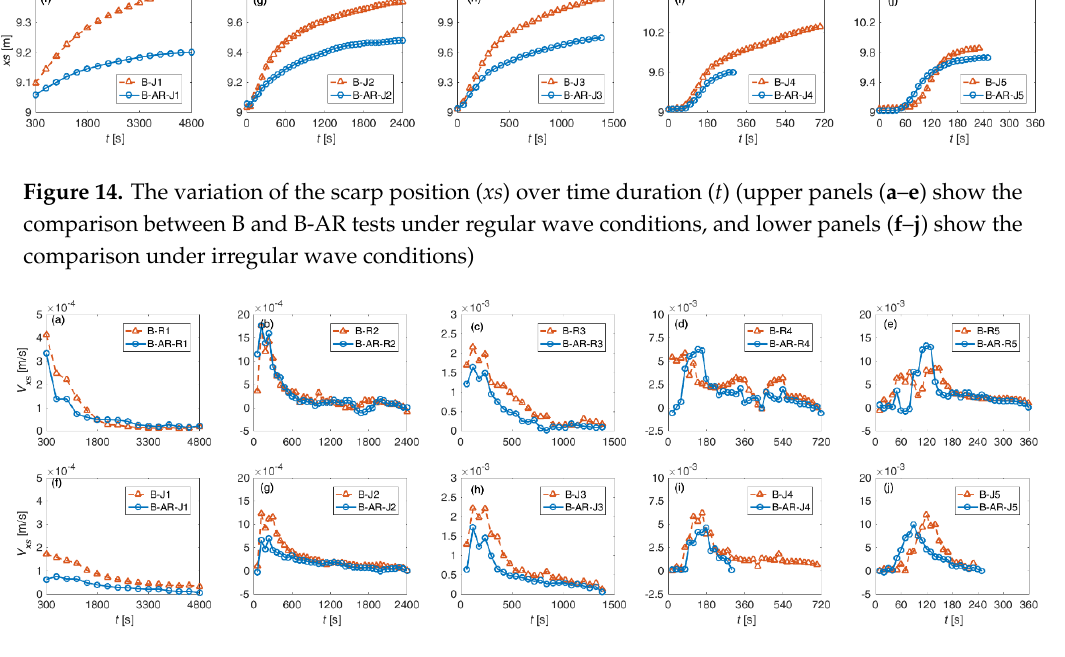
Figure 15. The change of the scarp retreat rate ( V xs ) over time duration ( t ) (upper panels ( a )–( e ) show the comparison between B and B-AR tests under regular wave conditions, and lower panels ( f )–( j ) show the comparison under irregular wave conditions) Table 7. Fitting parameters of scarp model.